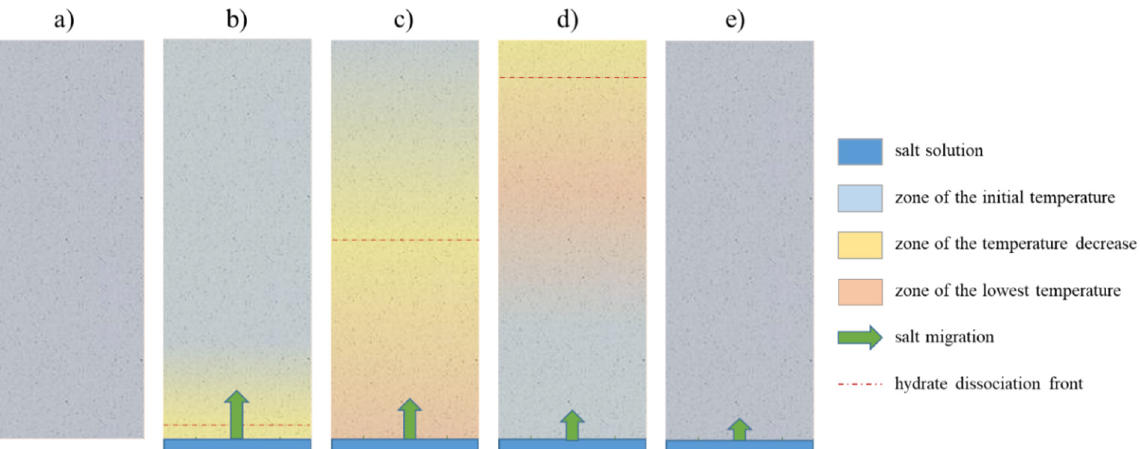
Figure 12. Temperature variations associated with salt transport in hydrate-saturated frozen sedi- ments. Detailed description in the text.